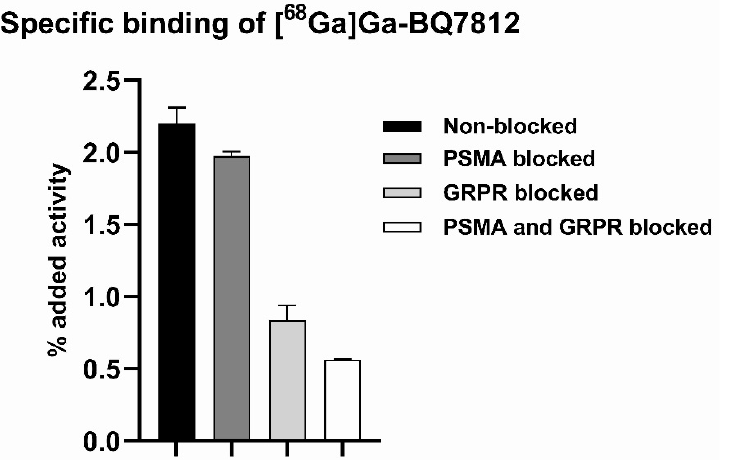
Figure 2. In vitro binding specificity of [ 68 Ga]Ga-BQ7812. Blocking was performed by the addition of non-labelled PSMA-11 and/or non-labelled NOTA-PEG 2 -RM26 (500 nM/well). Statistical analysis was done using one-way ANOVA with Bonferroni’s test corrected for multiple comparisons. A statistically significant difference was seen between all groups.